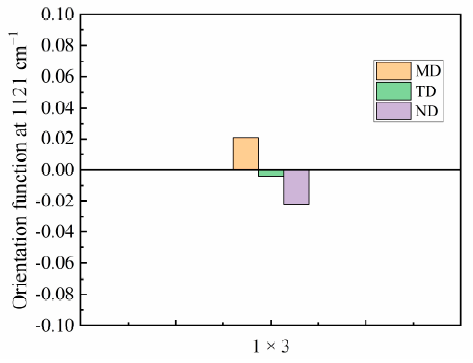
Figure 6. Orientation function of amorphous phase at 1121 cm − 1 for 1 × 3 PA510/SiO 2 films.